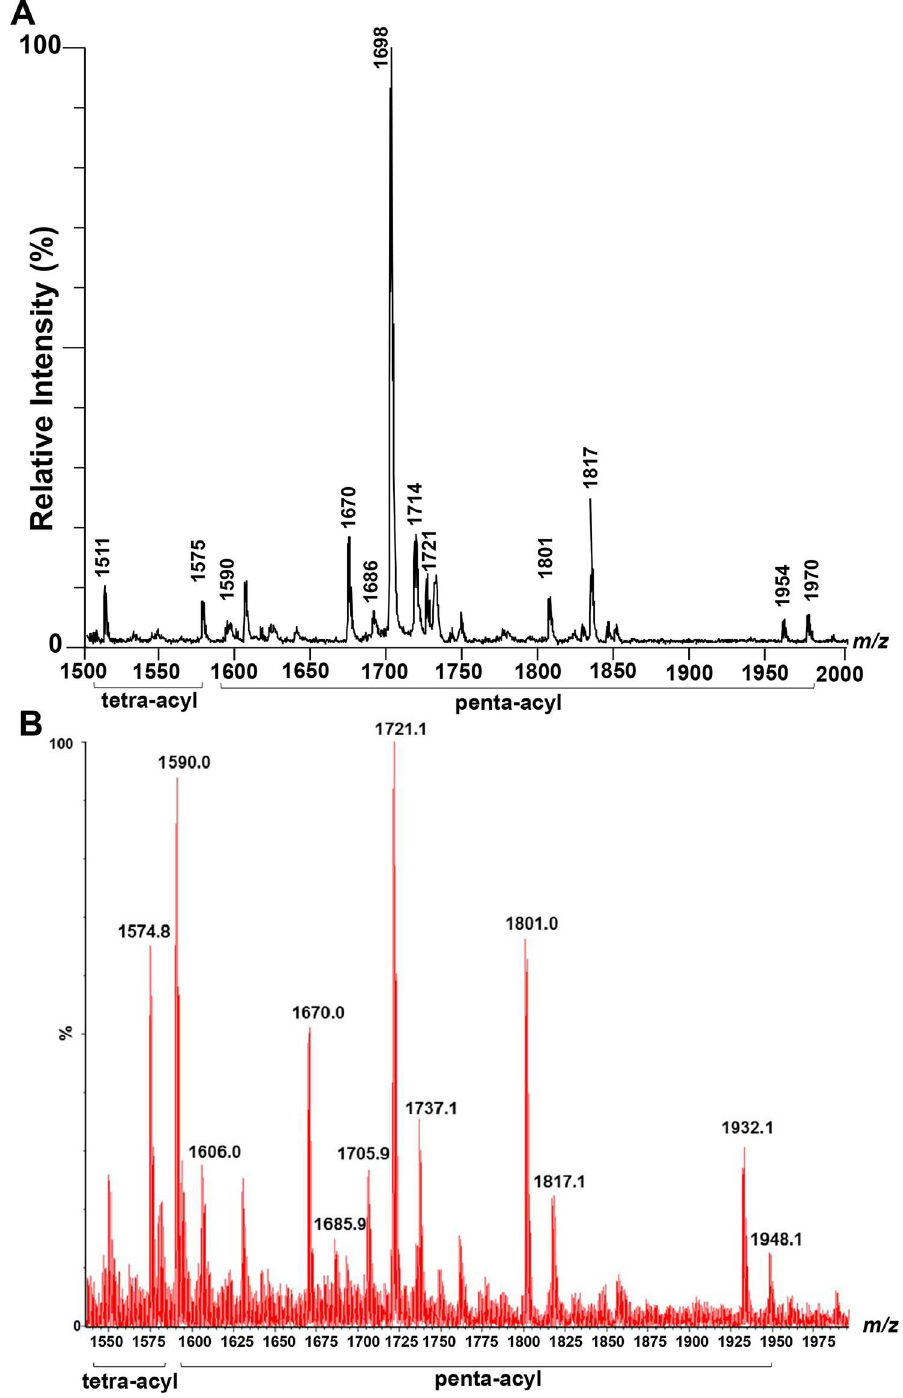
Fig 1. Negative ion mass spectrum by MALDI-TOF (A), by ESI (B) of B . pseudomallei K96243 lipid A. were detected only by MALDI-TOF and could not be detected for structural identification by ESI-QqTOF.